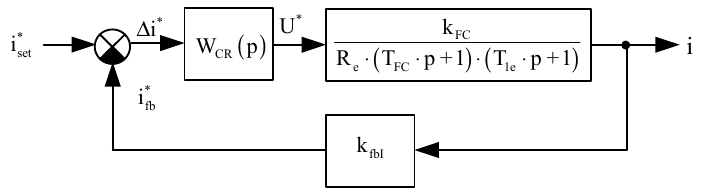
Figure 3. Structural scheme of the current control channels (* values presented in relative units of measurement).